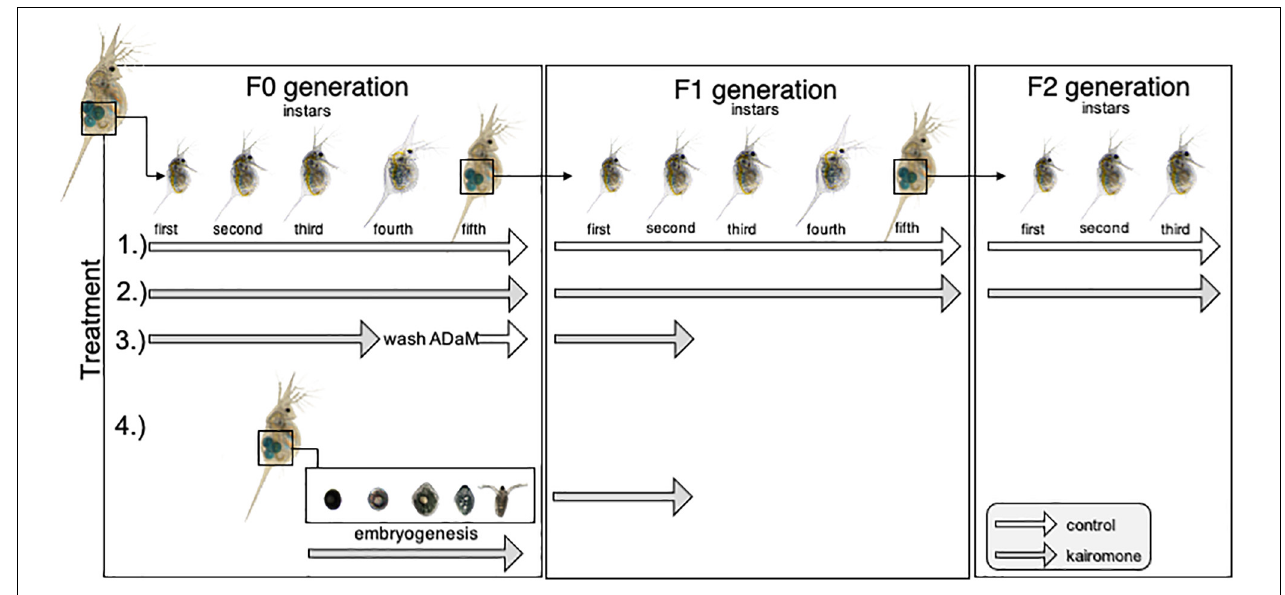
FIGURE 1 | Schematic display of kairomone exposure. 1.) In the control treatment, animals were never exposed to kairomones throughout the whole experiment. 2.) In the permanent kairomone exposure treatment individuals were permanently exposed to kairomones across all three generations. 3.) In the maternal kairomone exposure treatment animals were exposed to kairomone from the 1st until the 4th instar, then washed to remove residual kairomone, and transferred to kairomone-free medium. The 1st clutch was discarded and after being release from the brood pouch the 2nd and 3rd clutch were again exposed to fish kairomone. 4.) In the embryonic kairomone exposure treatment embryos in the mother’s brood pouch were exposed to fish kairomone from ovulation until being released from the brood pouch and continuously exposed until they reached the 2nd juvenile instar. Treatments 3.) and 4.) were raised until the second juvenile instar in the F1